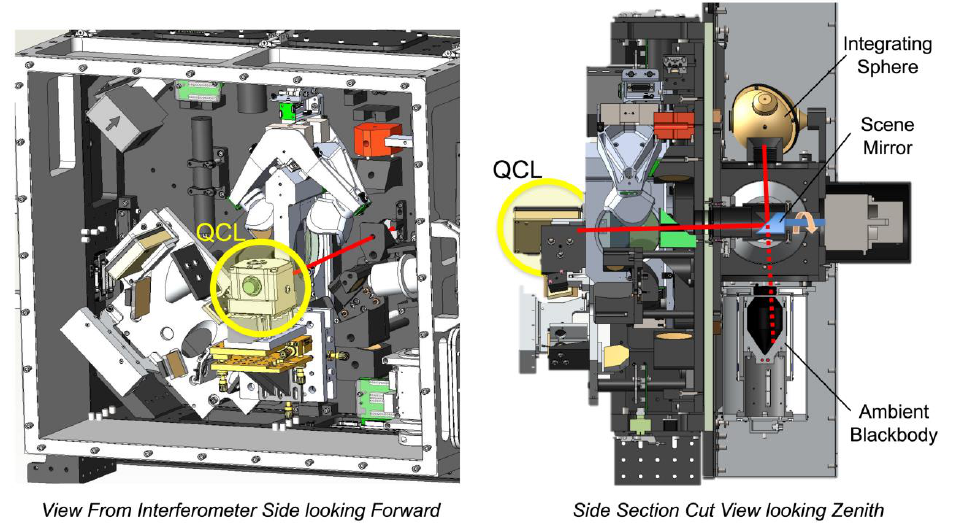
Figure 24. The Quantum Cascade Laser (QCL) is injected to the center of the 45° Scene Mirror from the back of the optical system, allowing all targets to be illuminated in identical fashion, while being viewed by the Fourier Transform Spectrometer